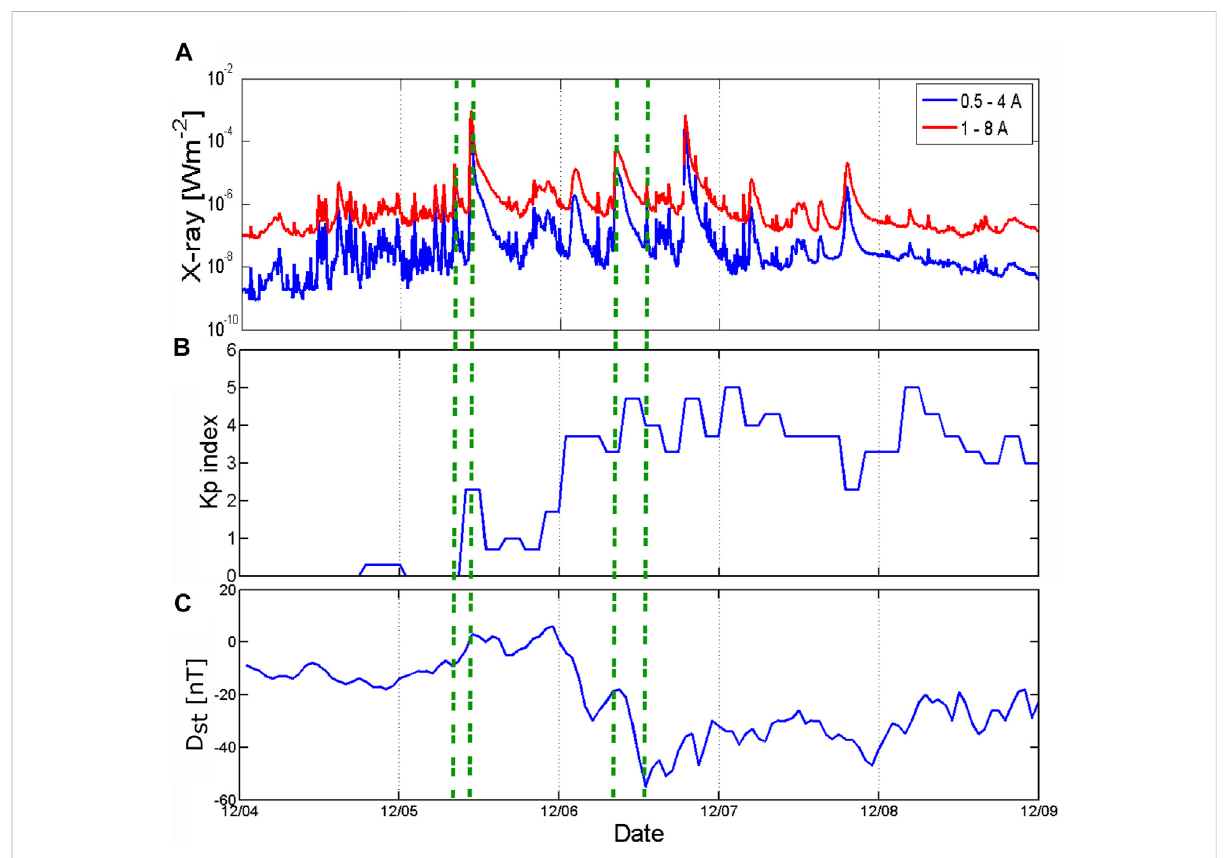
FIGURE 4 TheX-raychanges (A) ,thehourlymeanvariationoftheKp (B) andtheDst (C) indexesbetween04-12-2006and08-12-2006,respectively.The time of the investigated fl are events (M1.8 and X9 class on 05 December; M6 and C4.8 class on 06 December) are indicated by green dashed